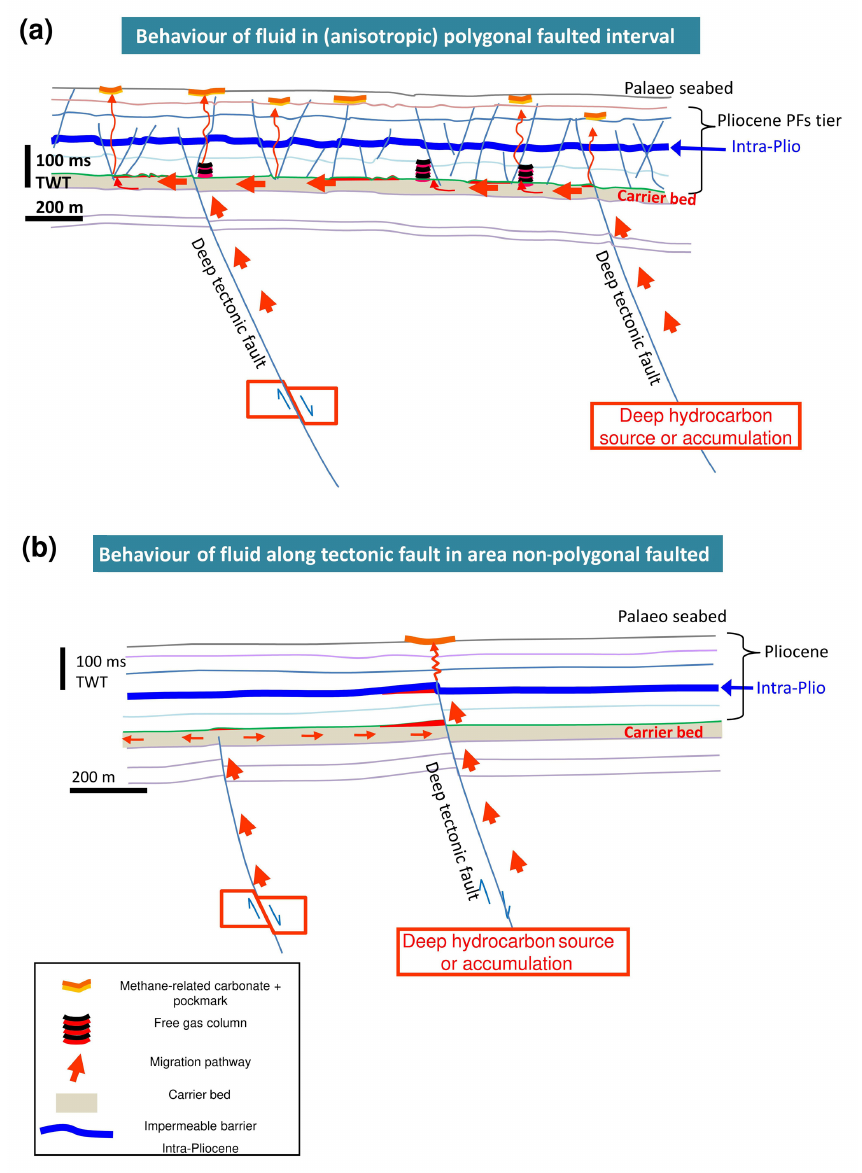
Figure 18. Conceptual models for two styles of gas migration into intervals with or without polygonal faulting. (a) Drawings show the trajectories of gas migration pathways branching out along the bottom of the PF tier. (b) Migration pathways focused along tectonic fault within the Pliocene